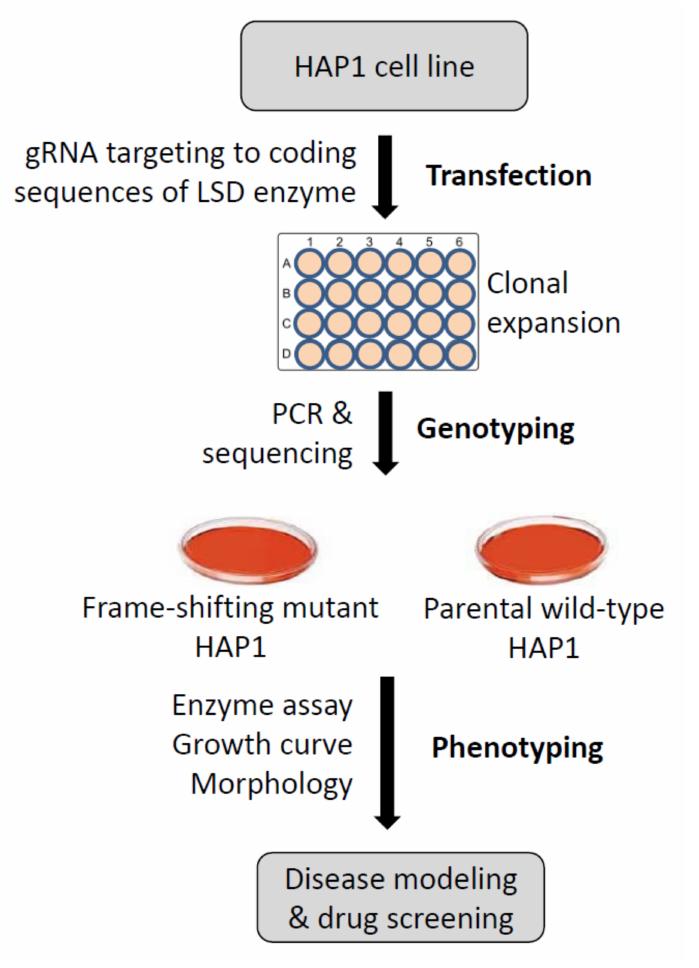
Figure 4. Streamlined protocols for generating LSD cell models using HAP1 cell line. Targeted gene editing using CRISPR-Cas9 enables a high rate of frame-shifting mutations and a premature termination of LSD enzymes in the near-haploid human cell line HAP1. Following initial gene editing and clonal expansion, desired enzyme mutants are obtained and confirmed by both genome typing and enzyme assays. Together with the parental HAP1, these mutants are useful resources for disease modeling and drug development of